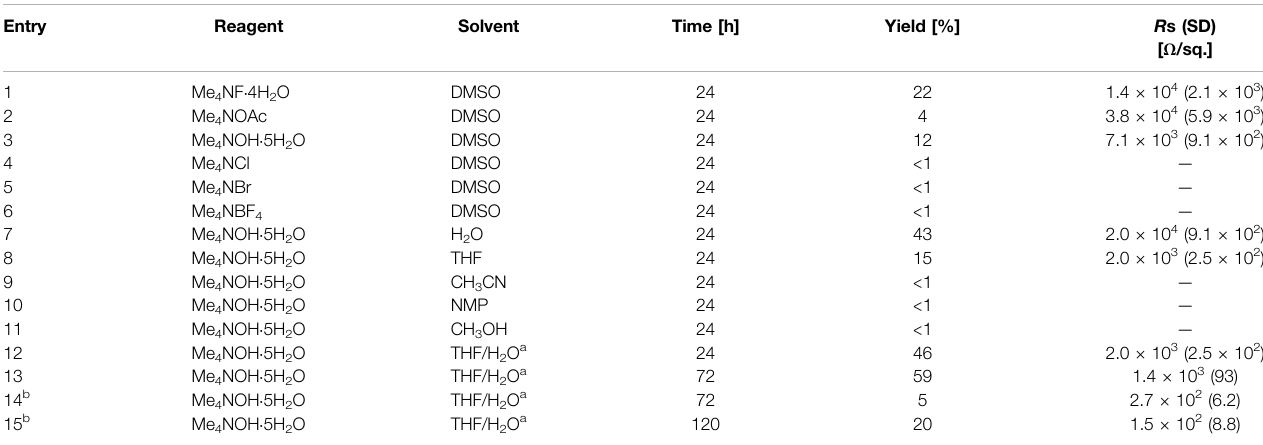
TABLE 1 | Optimized reaction conditions for exfoliating multilayer Ti 3 C 2 T x